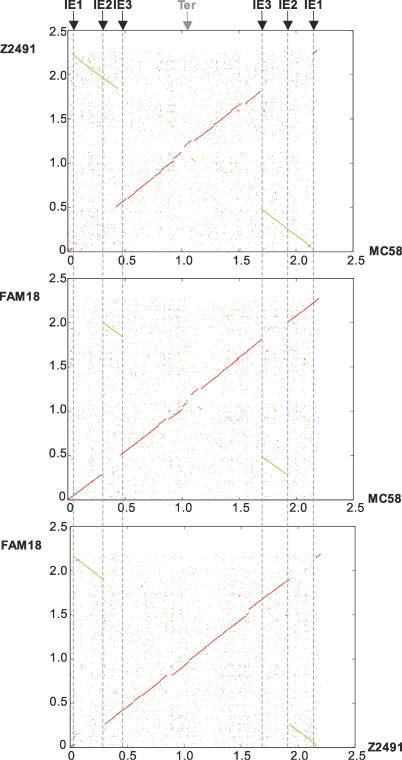
Rearrangements between the Meningococcal GenomesThe dotplots were generated using MUMmer version 3.15 (http://mummer.sourceforge.net) and indicate matching sequences with codirectional and reversed regions of synteny shown in red and green, respectively. Genome sequences are aligned to start/finish at the origin of replication with the approximate position of the terminus of replication indicated (Ter) (note this required rotation of the publicly available sequences for Z2491 and MC58, see Materials and Methods). Also shown are the positions of the foci of the three major inversion events (IE1, IE2, and IE3, see text for detail).